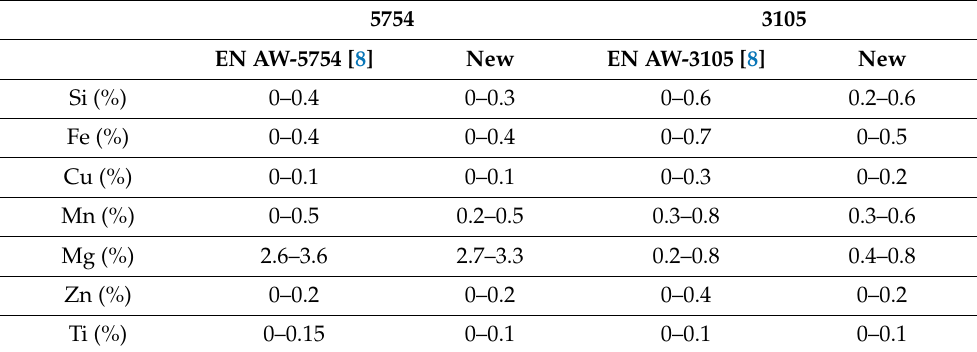
Table 2. Chemical composition of the new 5754 and 3105 alloys and their difference s with standard